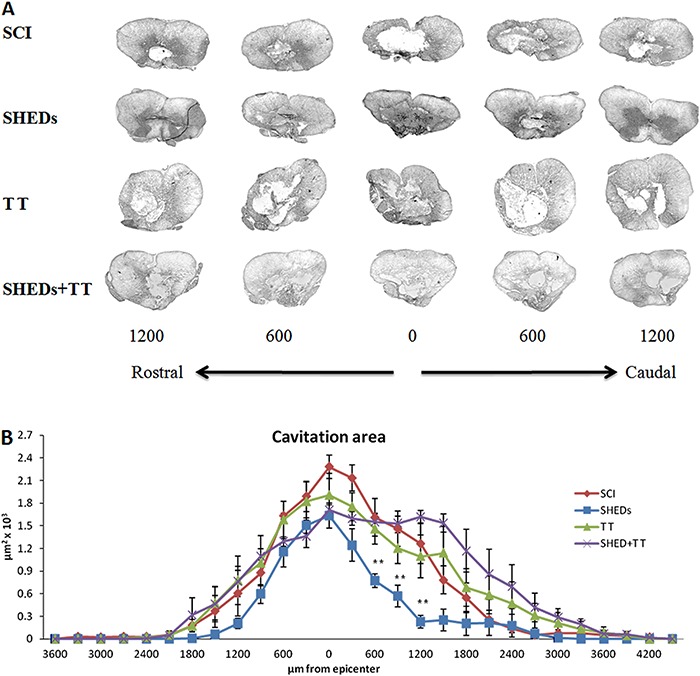
Representative images of cavitation areas (A) and cavitation area analysis (B) of incomplete spinal cord injury (SCI), SCI treated with stem cells from human exfoliated deciduous teeth (SHEDs), SCI treated with treadmill training (TT), and SCI treated with SHEDs and treadmill training (SHEDs+TT) rats. Data are reported as means±SE. **P<0.05, SHEDs group compared to SCI group (one-way ANOVA followed by Tukey's post hoc test).